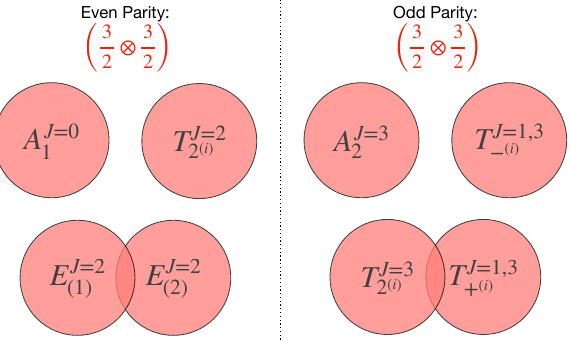
⊗ 3 electrons, with 2 2